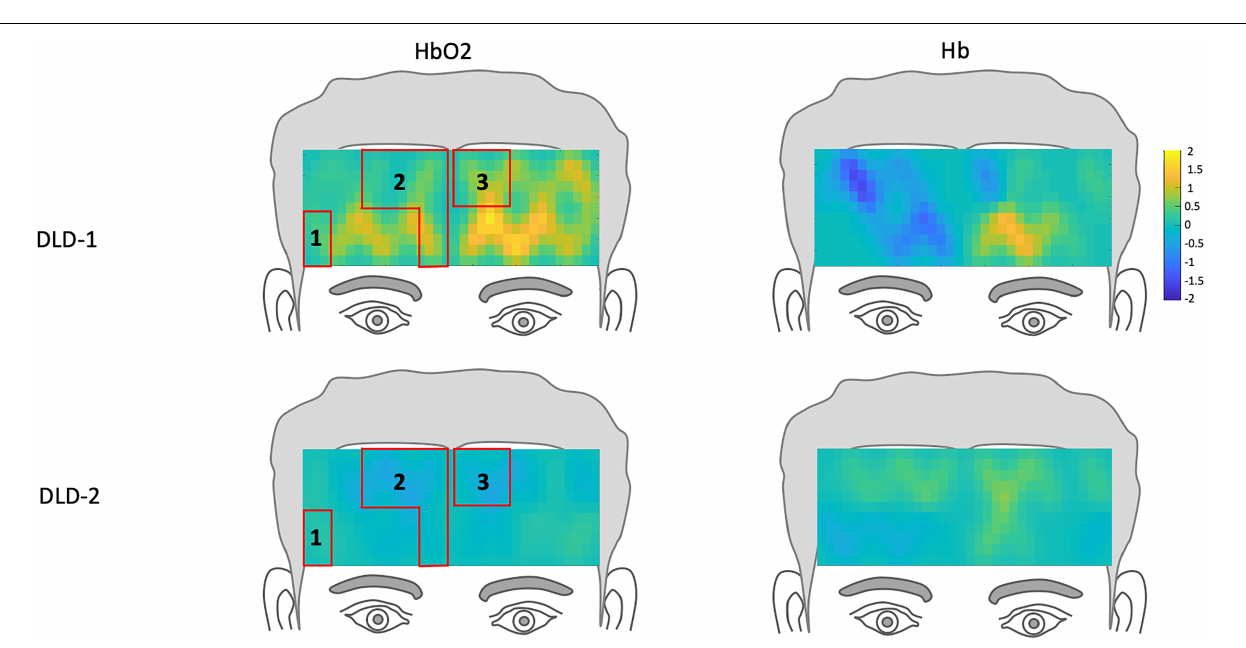
FIGURE 5 | Z -score topographs for DLD-1 and DLD-2 from pre-training, for low-frequency words for HbO 2 and Hb. ROIs established by the normal controls are outlined in red.